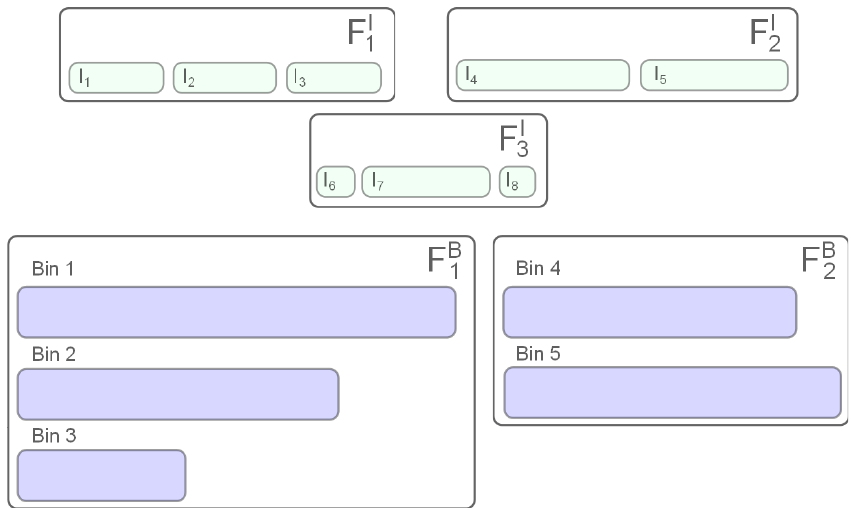
Figure 2. Item and bin